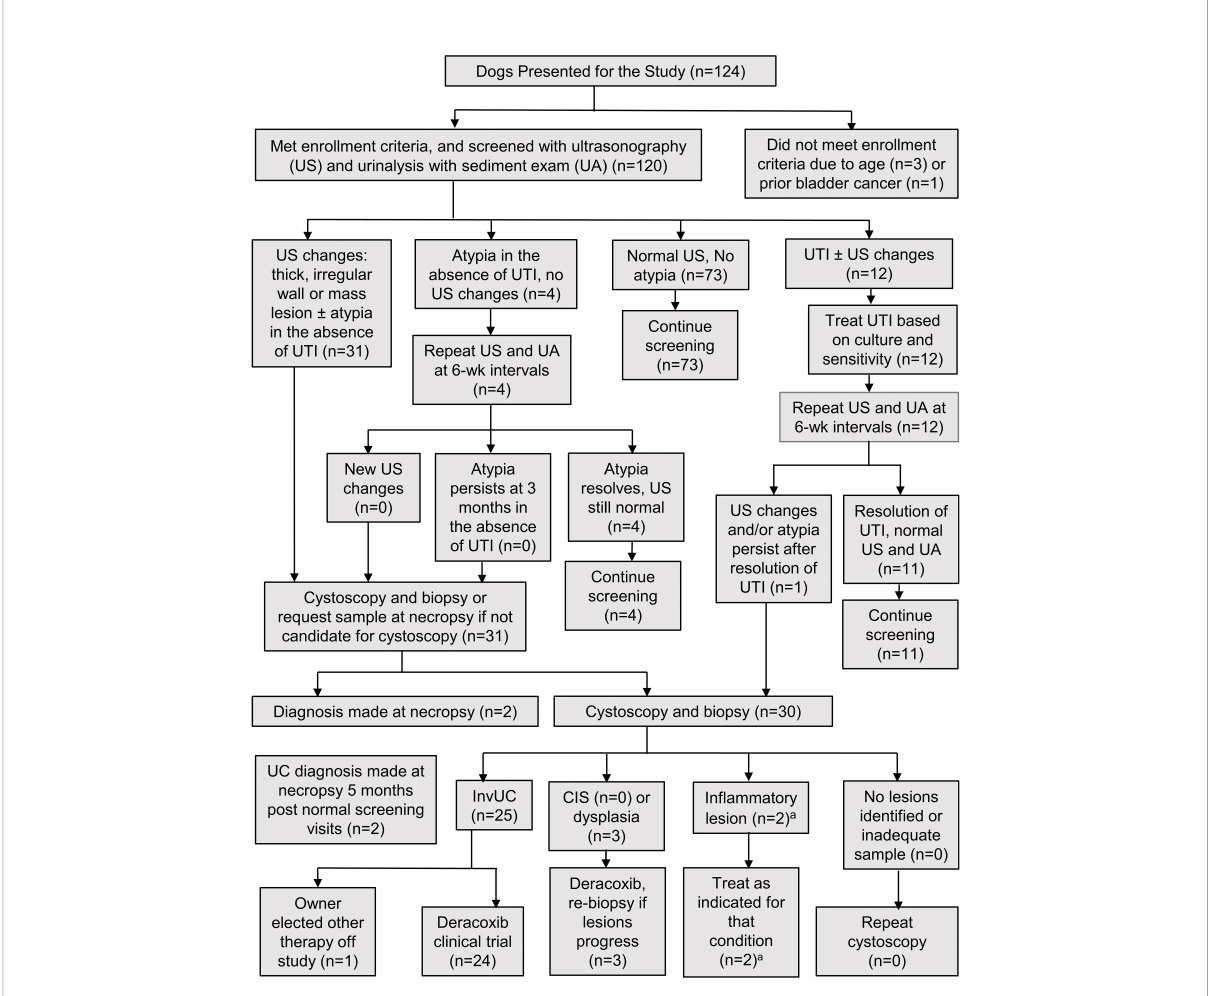
FIGURE 1 Flowchart of the screening procedures and management of dogs in the study. CIS, carcinoma in situ ; InvUC, invasive urothelial carcinoma; UA, urinalysis with sediment exam; UC, urothelial carcinoma; US, ultrasound exam; UTI, urinary tract infection. a Two dogs, 9 and 11.5 years old respectively, with thickened irregular mucosa, mass-like lesion, and epithelial atypia in urine sediment, had ulcerative cystitis identi fi ed in cystoscopic biopsy, and no evidence of progression at 16.5 and 54 months,